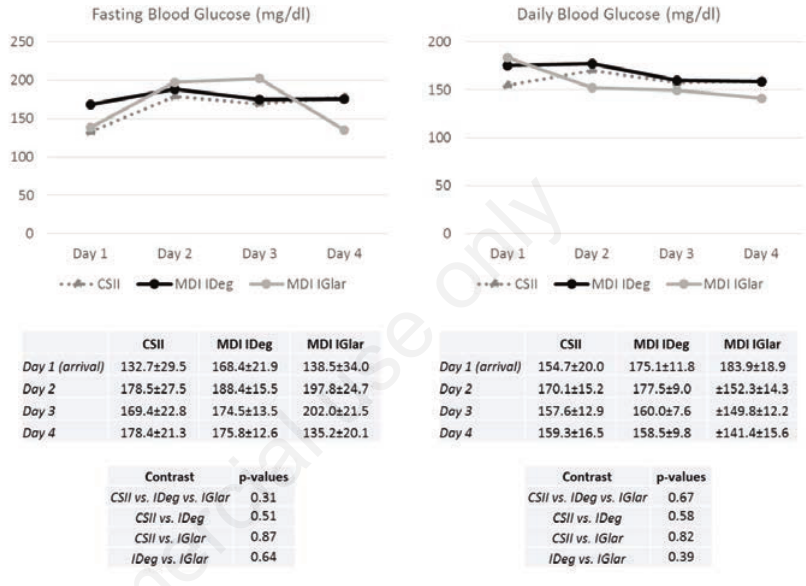
Figure 1. Trends by day and by insulin regimen of blood glucose levels. Data expressed as estimated means and standard